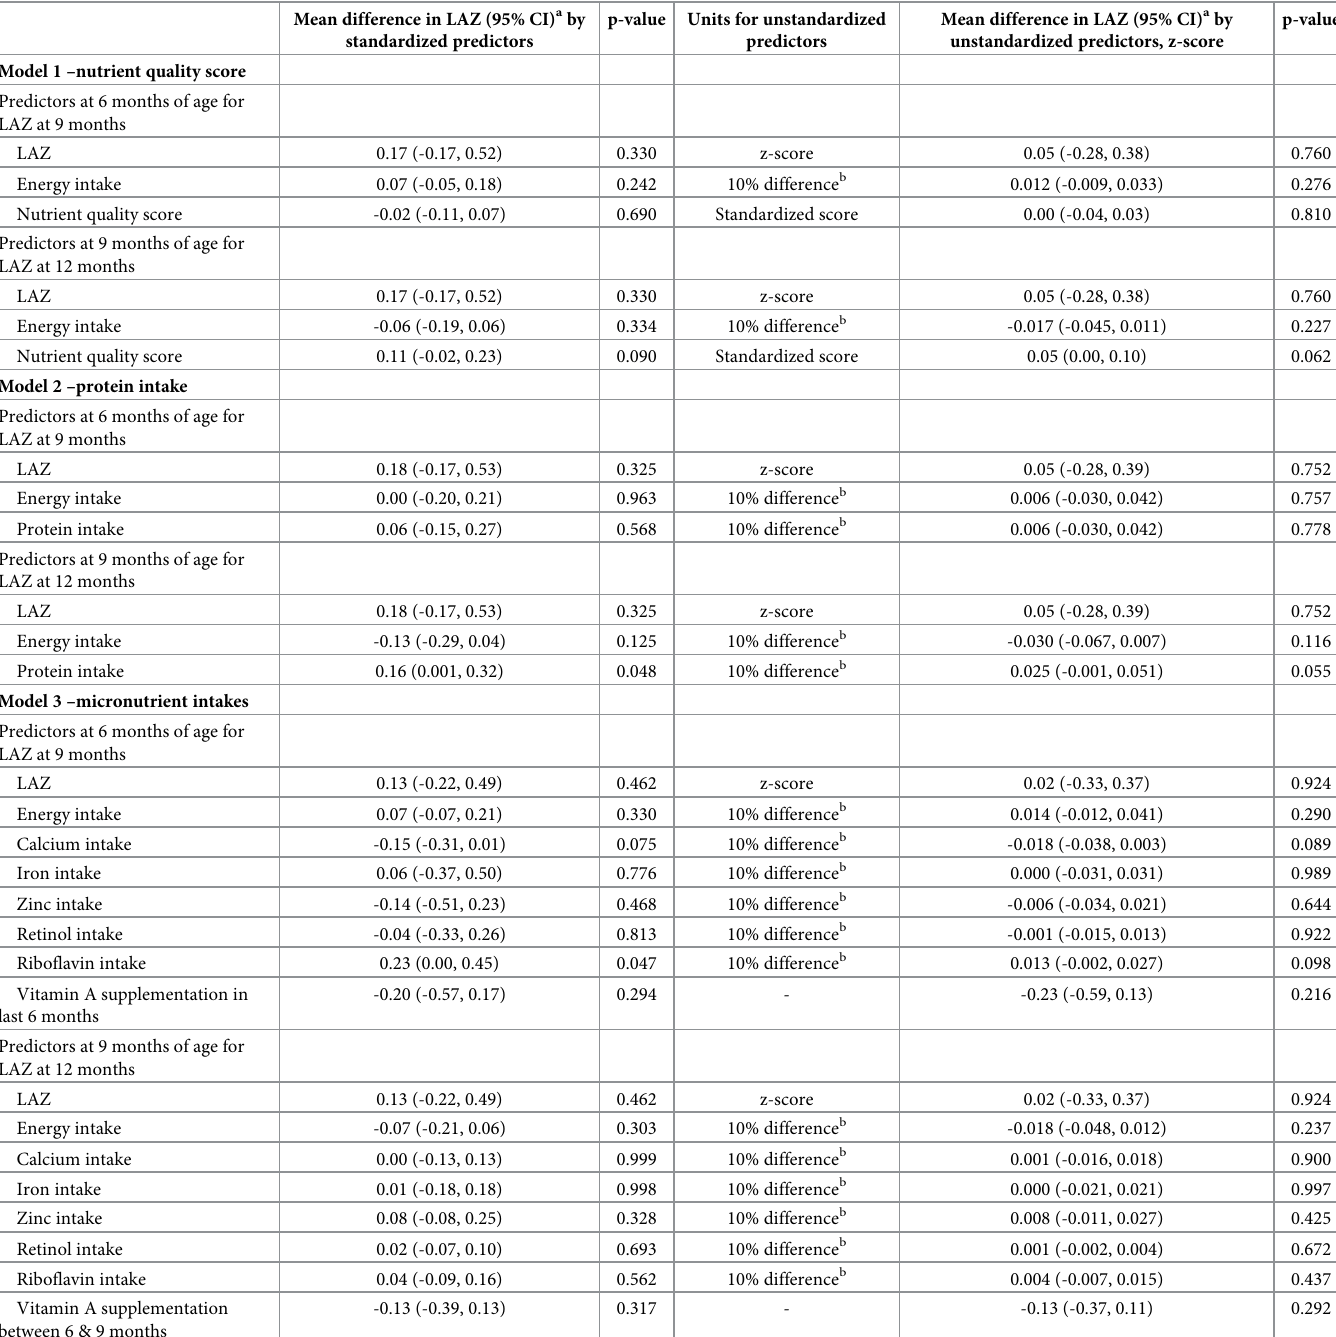
Table 5. Nutrient predictors of length-for-age z-score (LAZ) at 9 and 12 months of age (n = 225). Mean difference in LAZ (95% CI) a by p-value Units for unstandardized Mean difference in LAZ (95% CI) a by standardized predictors predictors unstandardized predictors, z-score